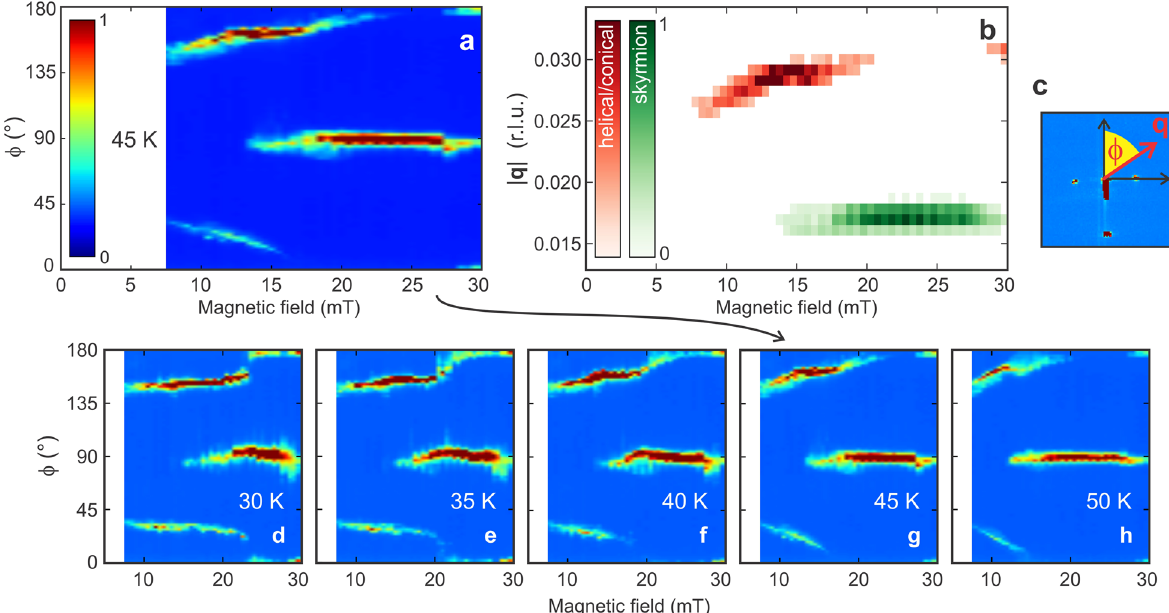
Fig. 4 Field dependence of the scattering vector in the helical/conical and skyrmion phase. Field-dependent scattered intensity maps for a the angle ϕ and b the magnitude ∣ q ∣ of the scattering vector, as de fi ned in c . The measurements shown in a and b were carried out at 45 K using the fi eld-cooling protocol. The temperature dependence of the ϕ - fi eld plots is shown for 30, 35, 40, 45, and 50 K, in d – h , respectively. The red and green color scale data in b correspond to the intensity from the helical/conical and skyrmion modulation, respectively. These intensity plots are obtained by integrating within the regions of interest for the conical/helical and fi rst-order skyrmion peaks as shown in Fig.